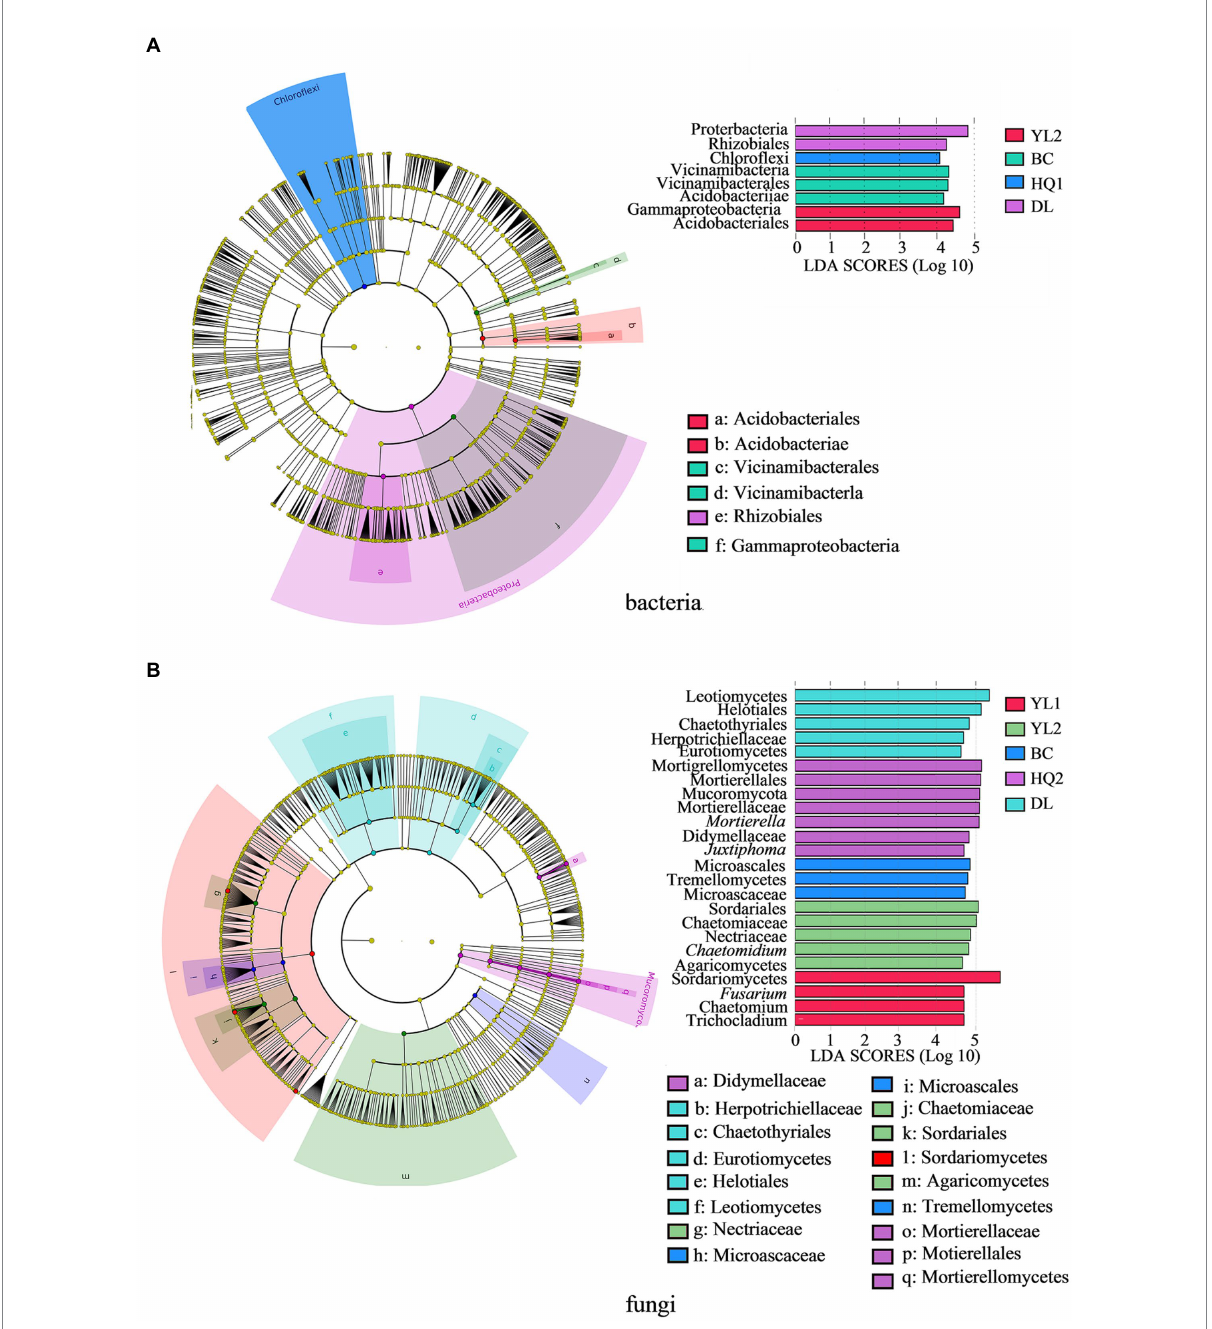
FIGURE 4 The LEfSe identifies the significantly different ( p < 0.05, Kruskal-Wallis test, linear discriminant analysis values >4.0) bacteria (A) and fungi (B) at multiple taxonomic levels in the six regions. Colored dots represent the taxa with significantly different abundances between sites, and from the center outward, they represent the phylum, class, order, family, and genus